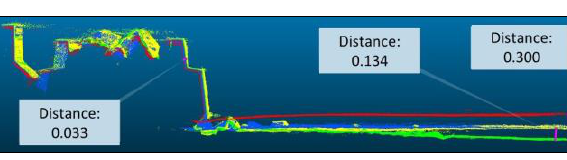
Figure 17 . Close view of the topographic variations